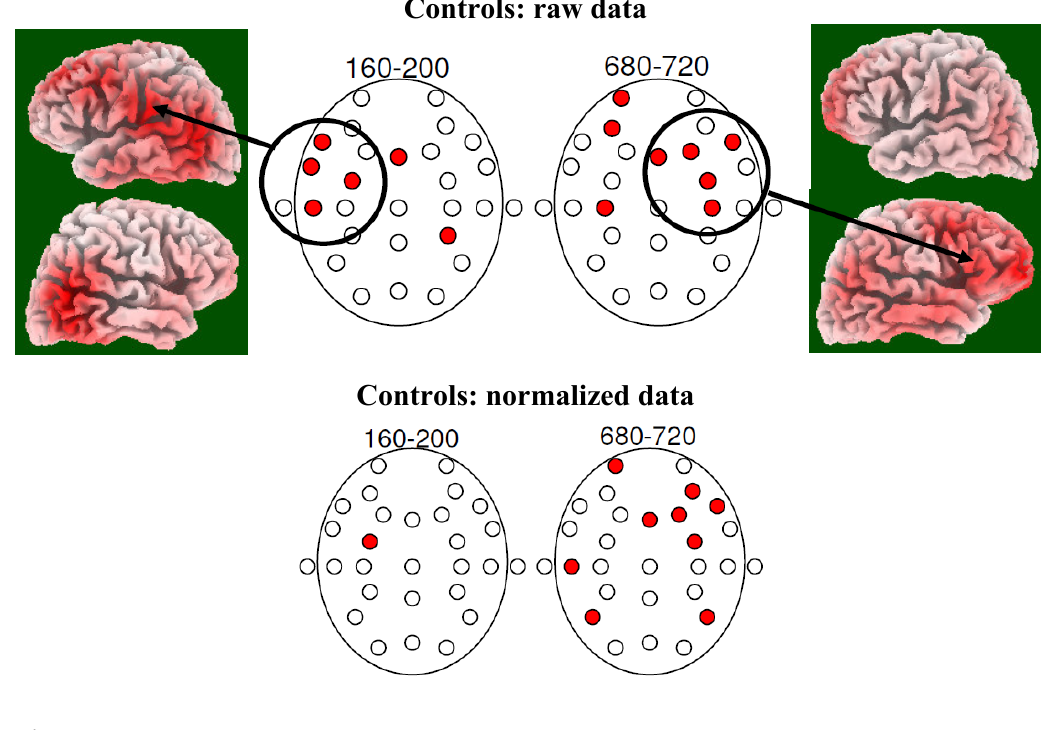
Figure 2. T-maps showing distributions of significant differences between the with-odour and the without-odour condition in age-matched controls. Note that controls show a number of significant effects at the left fronto-temporal area for the early time window and at the right fronto-temporal area for the later time window (raw data and normalised data). This situation matches nicely previous findings in young healthy study participants (Walla et al . 2003 [1]). In patients no such differences were